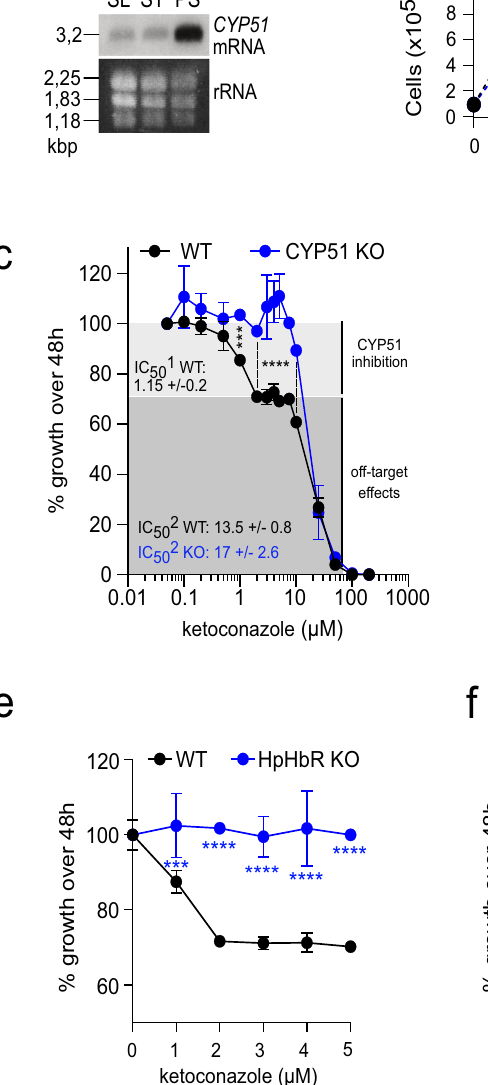
of the experimental design showing the inhibition of hemoprotein CYP51 activity by ketoconazole. e De fi ciency in the haptoglobin-hemoglobin (HpHb) uptake results in mild growth phenotype and insensitivity to the CYP51inhibitor.WT T. b. brucei and HpHbR knock-out (KO) were incubated for 48h with 0 to 5 μ M of ketoconazole( n =2).Sidak ’ smultiplecomparisonstest*** p <0.001;**** p <0.0001. f T. b. rhodesiense Etat 1.2R cells freshly isolated from mice and transferred to in vitro culture conditions with either normal human serum containing HpHb (Hp +/+), human serum lacking Hp (anhaptoglobinemic) (Hp − / − ), or anhaptoglobi- nemic serum complemented with puri fi ed human Hp (Hp − / − + Hp). Their growth rate was determined after incubation for 48h with 0 to 5 μ M of ketoconazole ( n =3). Dunnet ’ s multiple comparison test * p <0.1; ** p <0.01; *** p <0.001. Error bars indicate ±SD. Source data are provided as a Source Data fi